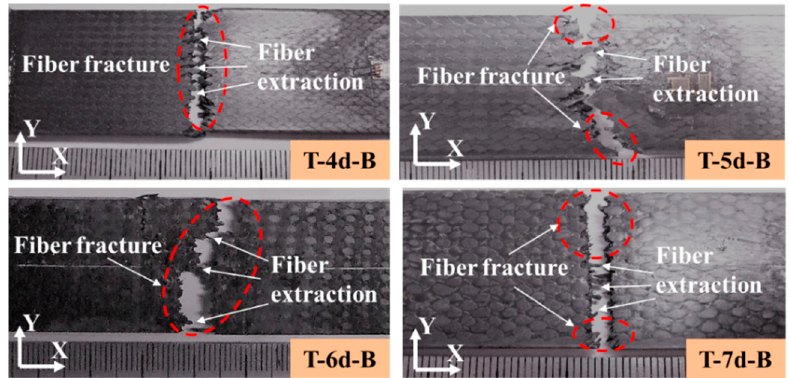
Figure 12. Tensile failure of 3DBC with a braiding angle of 40°.